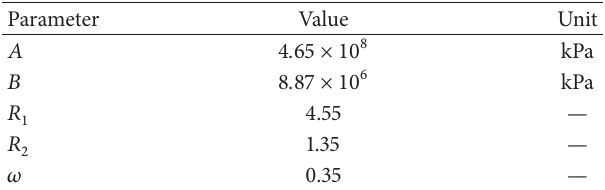
Table 1: Material coefficients in Jones-Wilkins-Lee (JWL) equation for HNS 1.65.